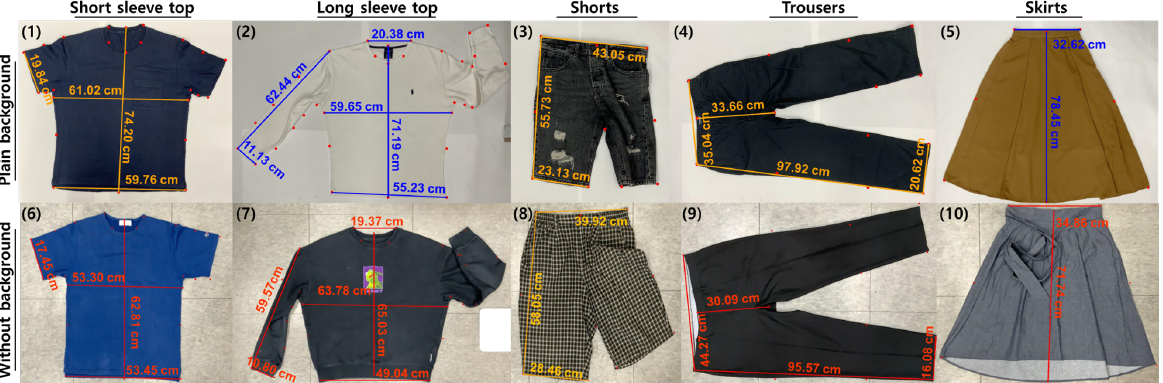
Figure 2. Some examples of size measurement results. These results show the robustness of the point detector model to the shape, orientation, color, and background. The left arm of the long sleeve top (2, 7) and left leg of the shorts (3, 8) were folded, and the skirt (10) had a different front/back shape. The trousers (4, 9) rotated 90° counterclockwise and the white long sleeve top (2) were the same color as the background; all parts were successfully